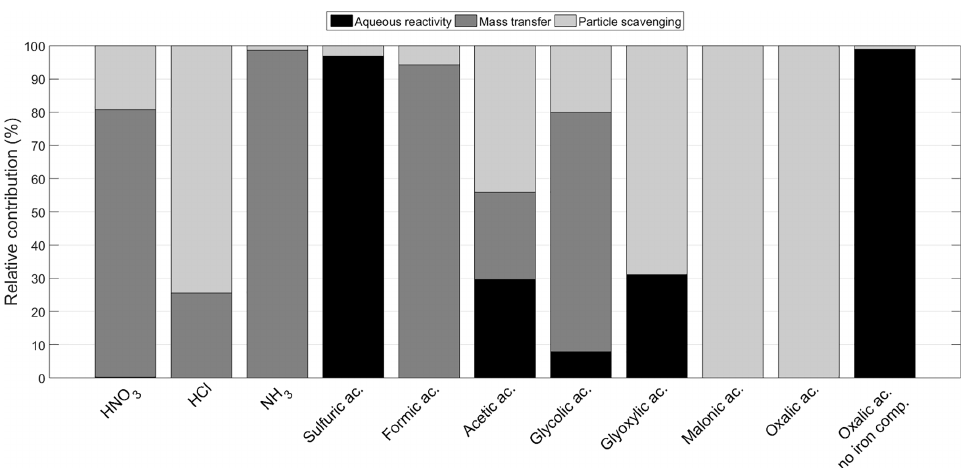
Figure 9. Relative contributions of particle scavenging, mass transfer and aqueous reactivity to the production of selected compounds during Run 3 (increased quantities of organics in the particle